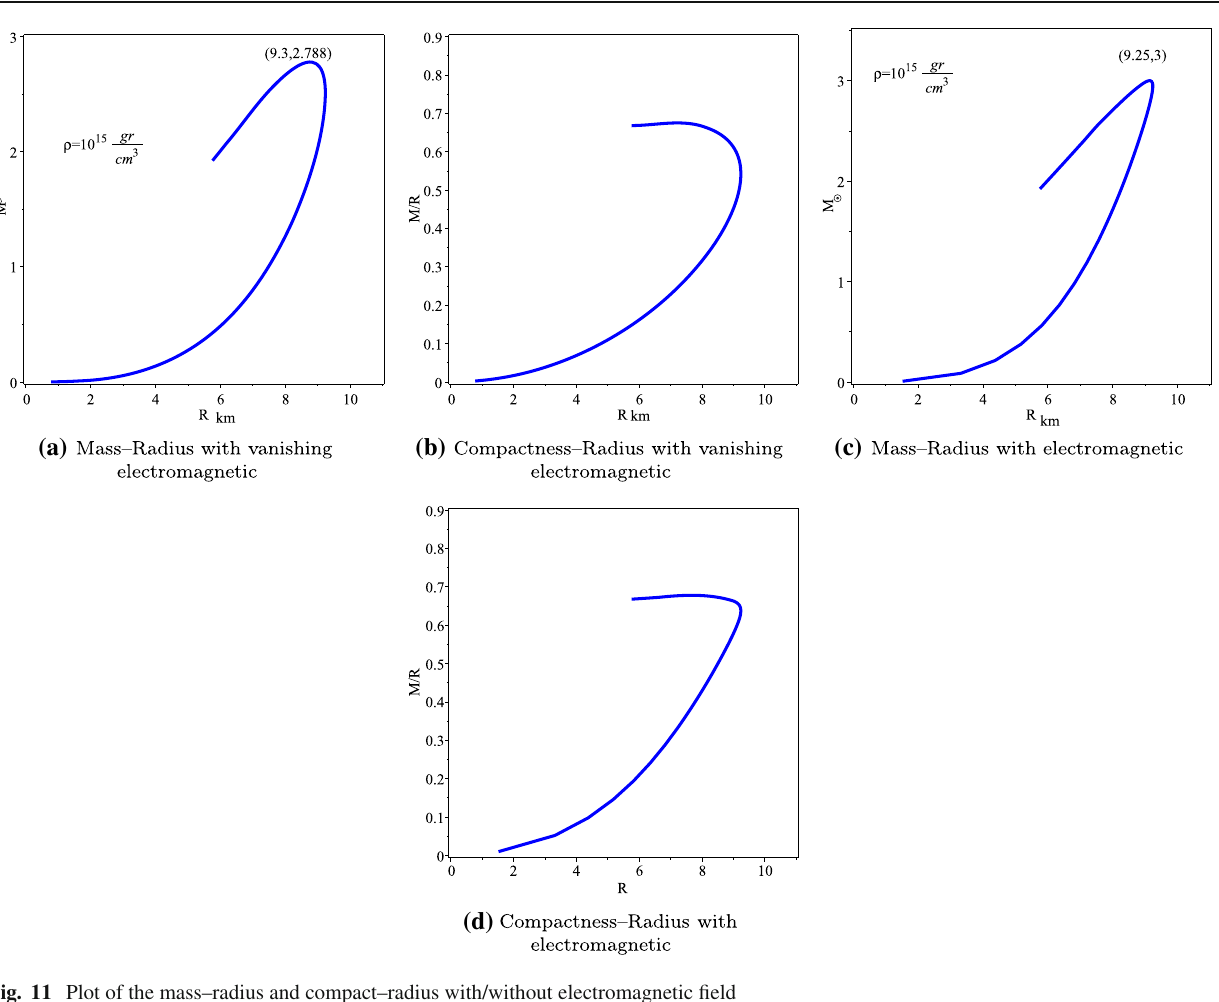
Fig. 11 Plot of the mass–radius and compact–radius with/without electromagnetic